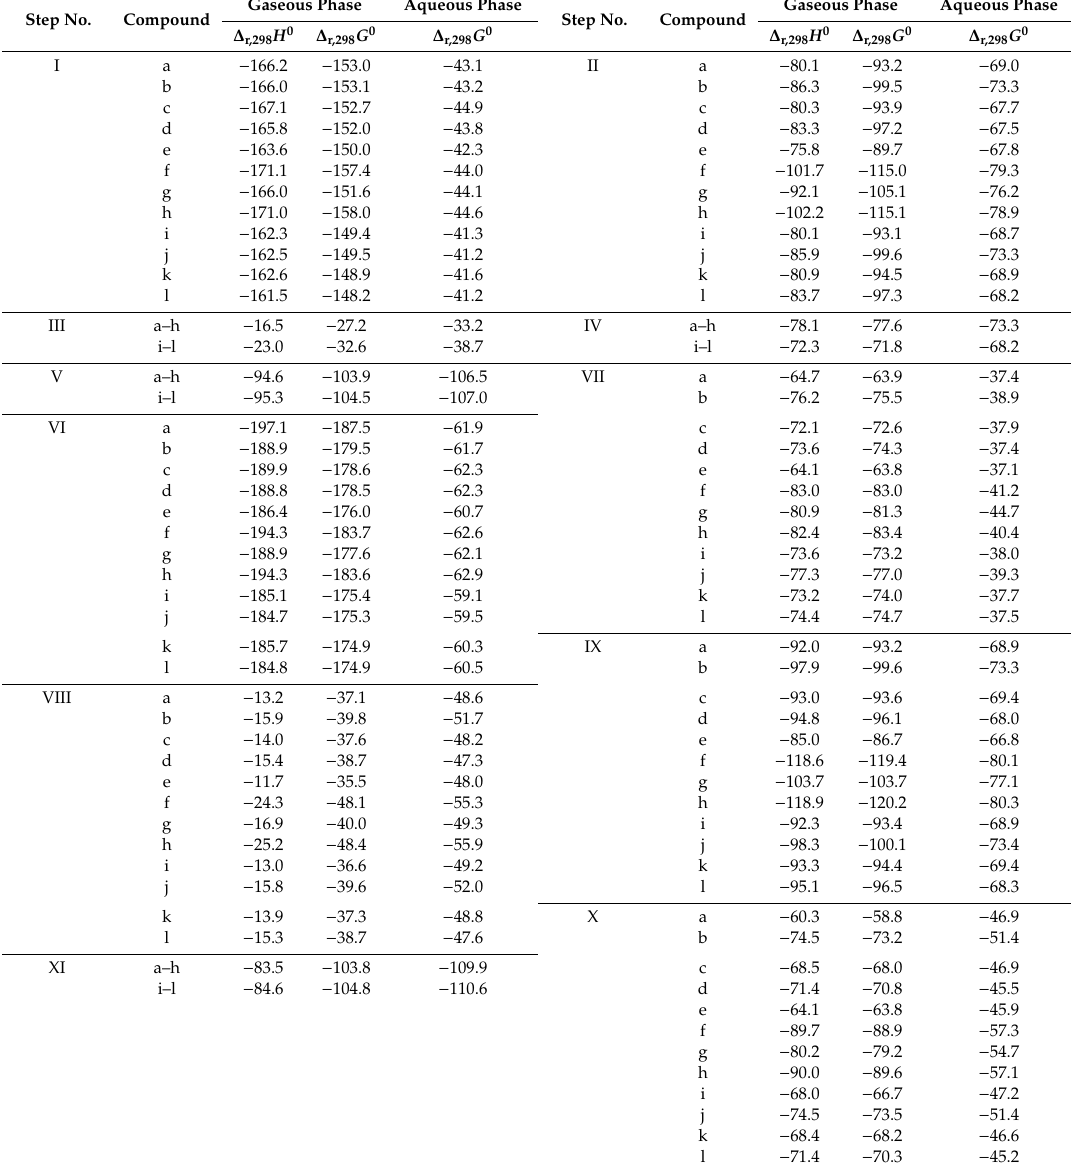
Table 1. Thermodynamic data 1 of the elementary steps of the reaction of ATE with OOH − and OH − . Step No.